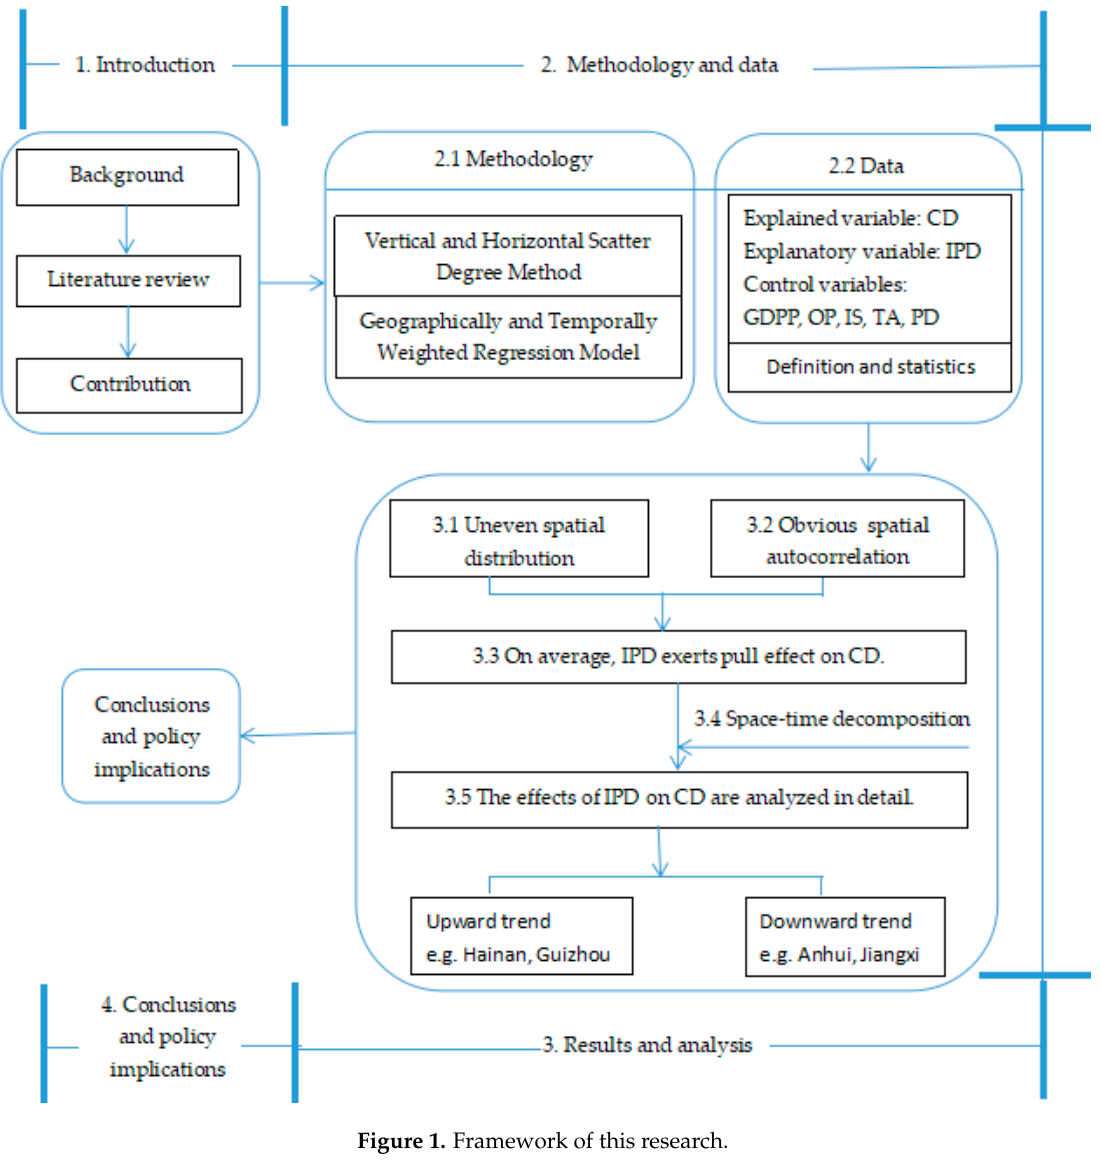
Figure 1. Framework of this research.